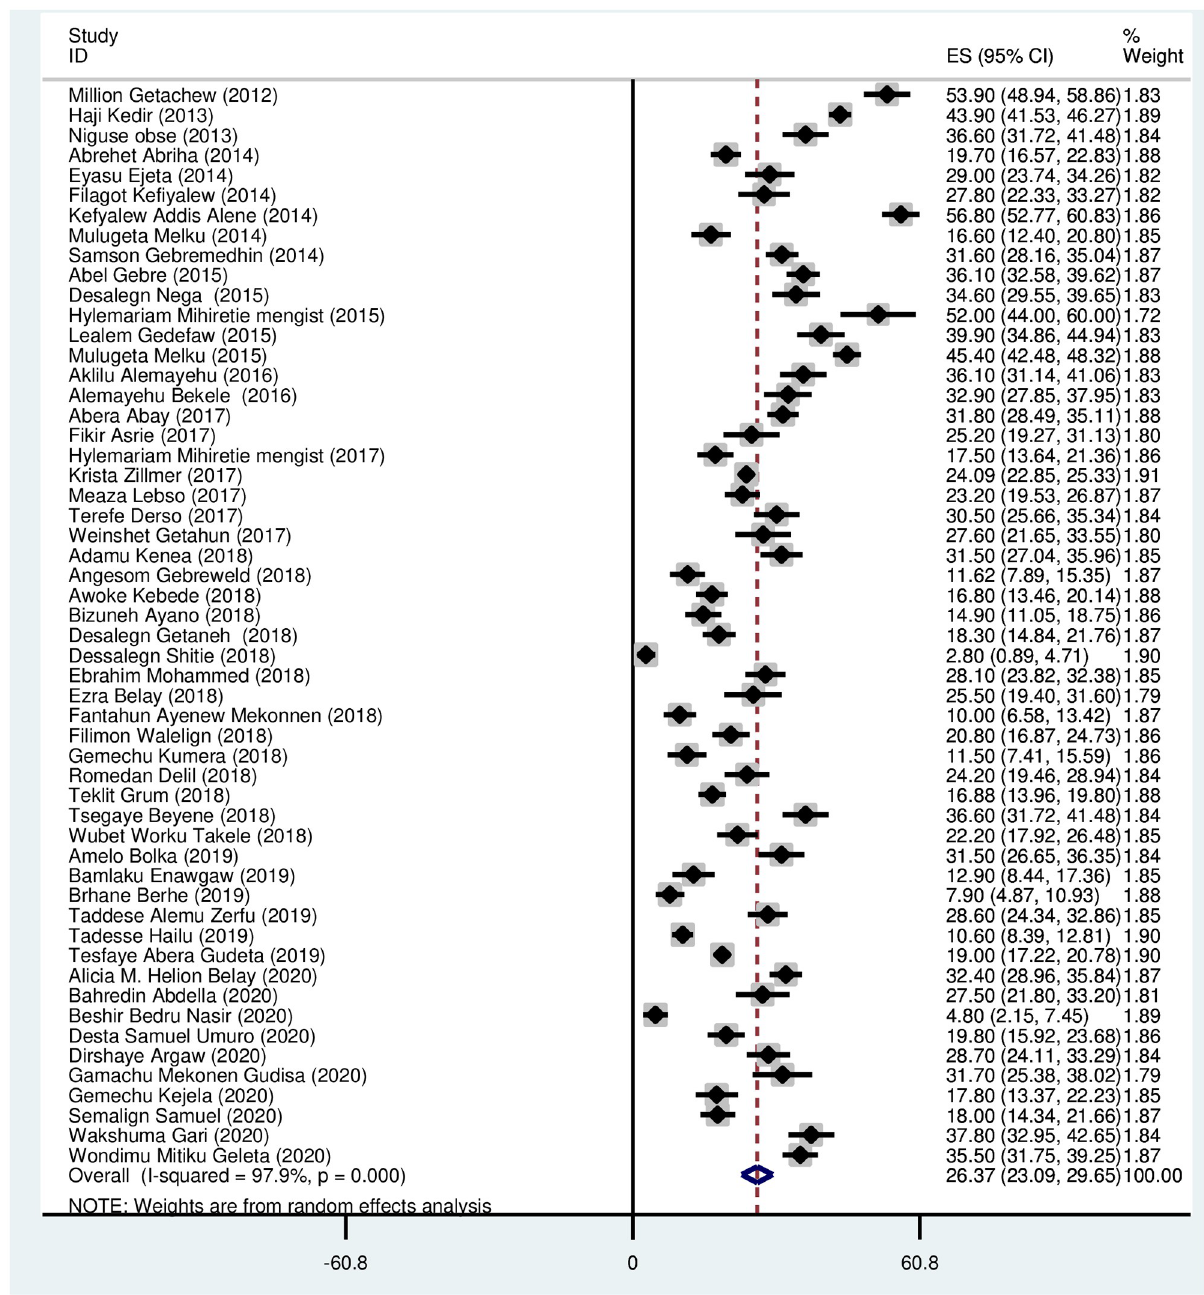
Fig 2. Forest plot on the prevalence of anemia among pregnant women in Ethiopia.